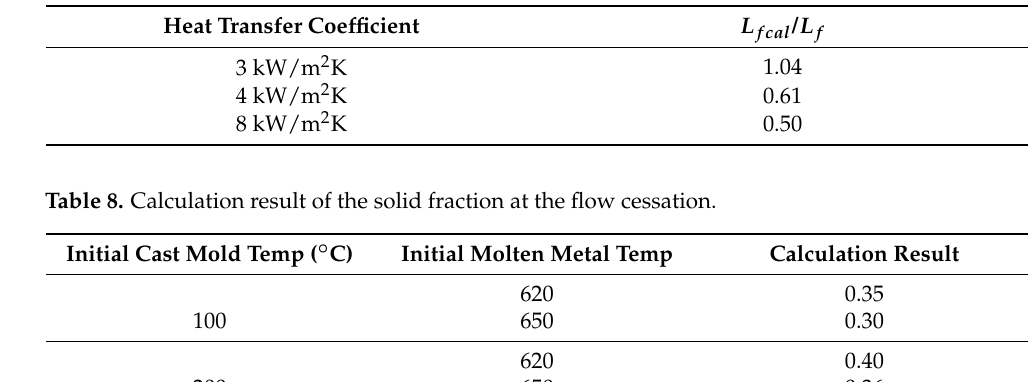
Table 7. Comparison of experimental and simulation data.